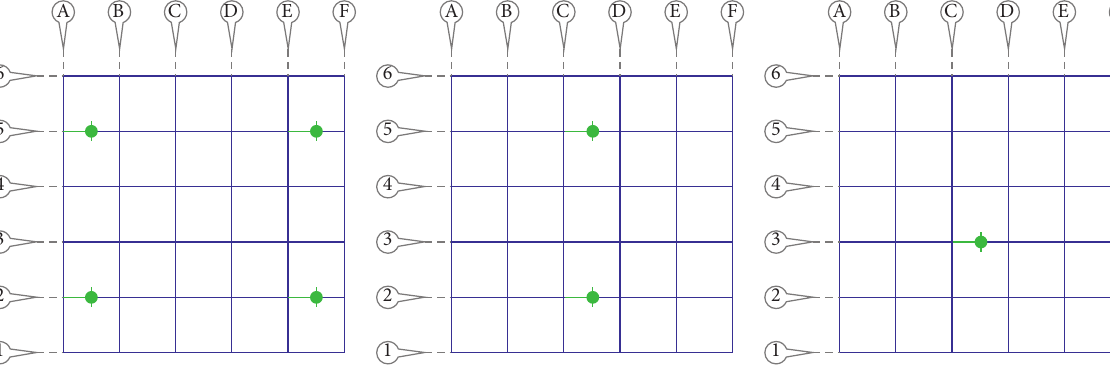
Figure 4: Damper at one point (right), dampers at two points (middle), and dampers at four points (left).